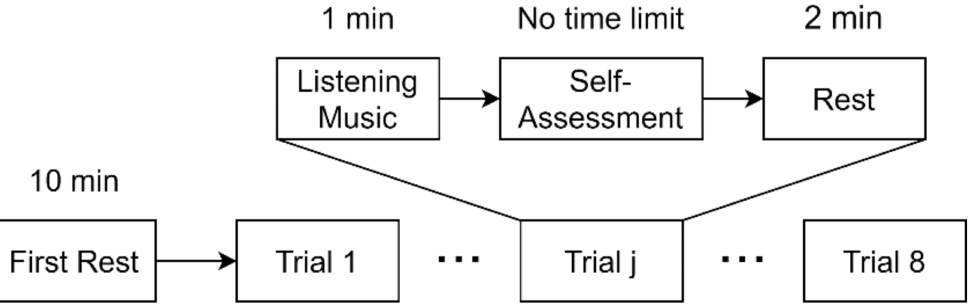
Figure 4. Experimental